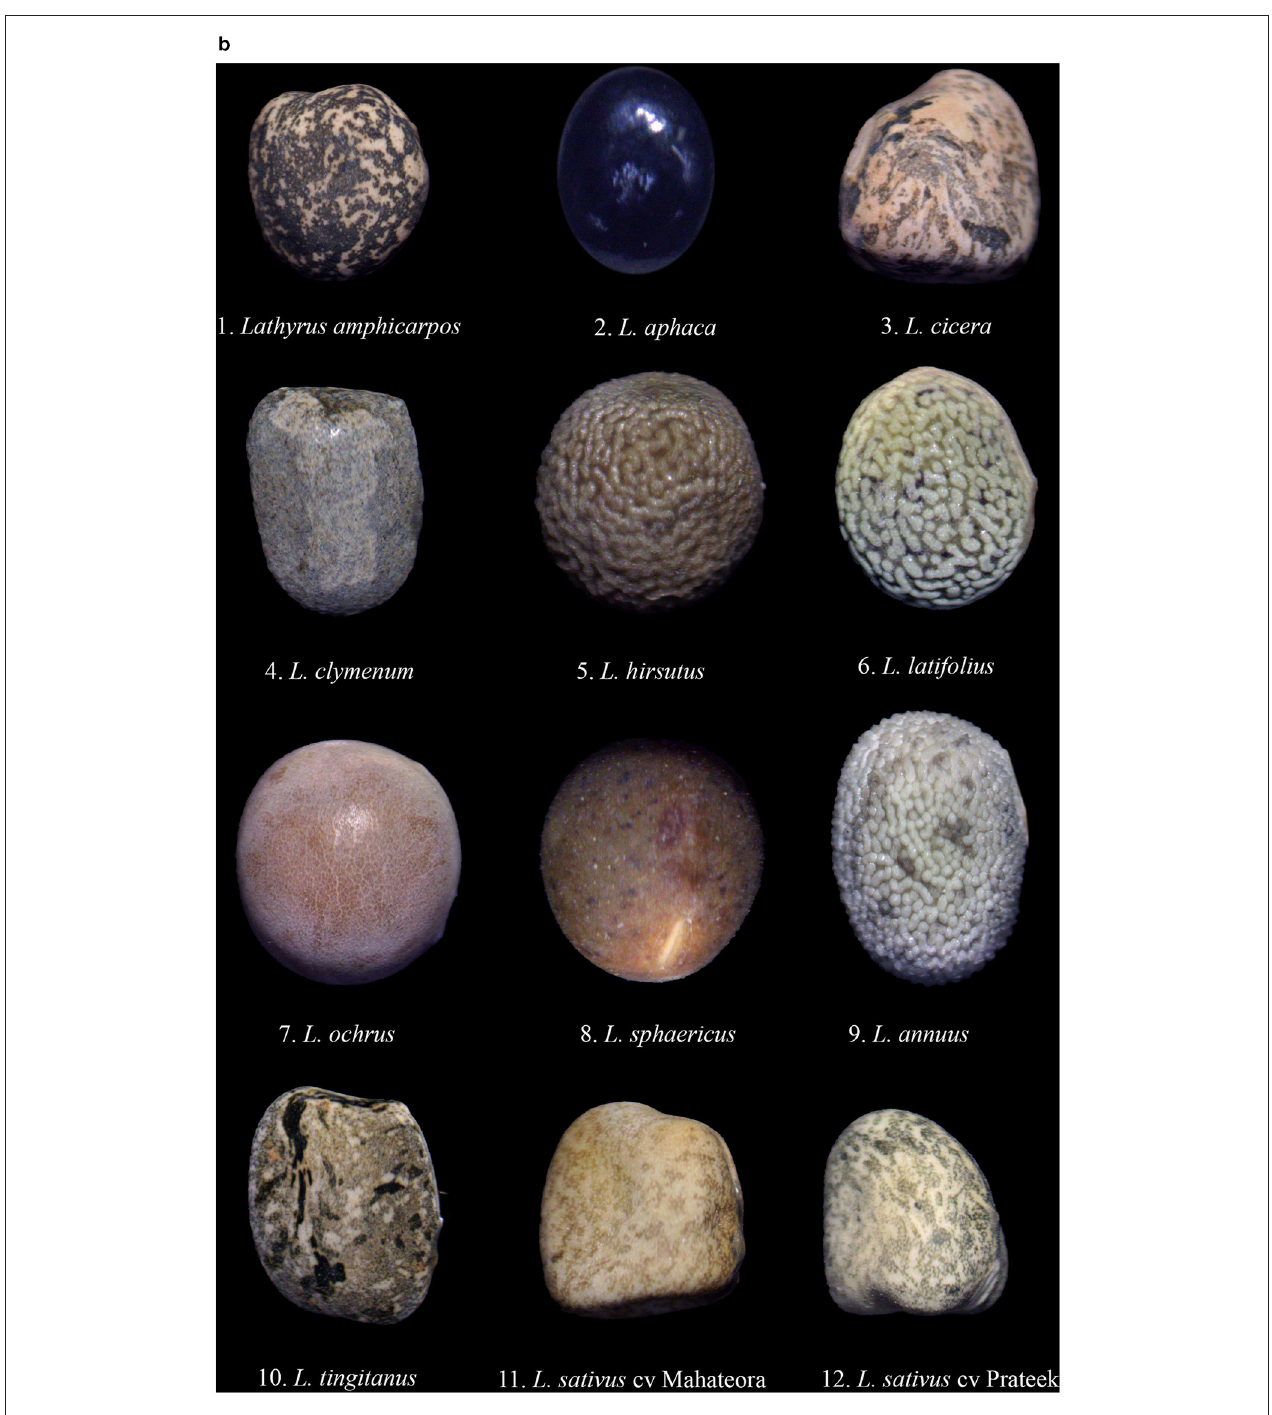
FIGURE 3 | (a) Leaf variation in different species of Lathyrus (top) and flower color variation (bottom) - (A) L. aphaca ; (B) L. cicera ; (C) L. odoratus ; (D–I) L. sativus. (b) Seed color variation in different species of genus Lathyrus . leaf, flower and seeds of some species of Lathyrus are depicted in various colors, including white, brownish-gray, yellow, and in Figures 3a,b . As described by Hanbury et al. (27); and are spotted or mottled (26). The hilum is elliptic with yellow to pinkish yellow cotyledons. The seeds germinate hypogeally Jackson and Yunus (19), grasspea accessions are broadly grouped with purplish-green epicotyls. The morphological variation in into two groups viz. (1) Blue-flowered accessions with